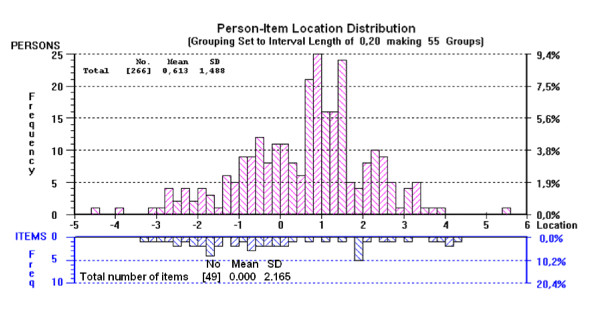
Targeting of "Activity-Participation" item bank to patient disability (after collapsing of the categories). (n = 266).